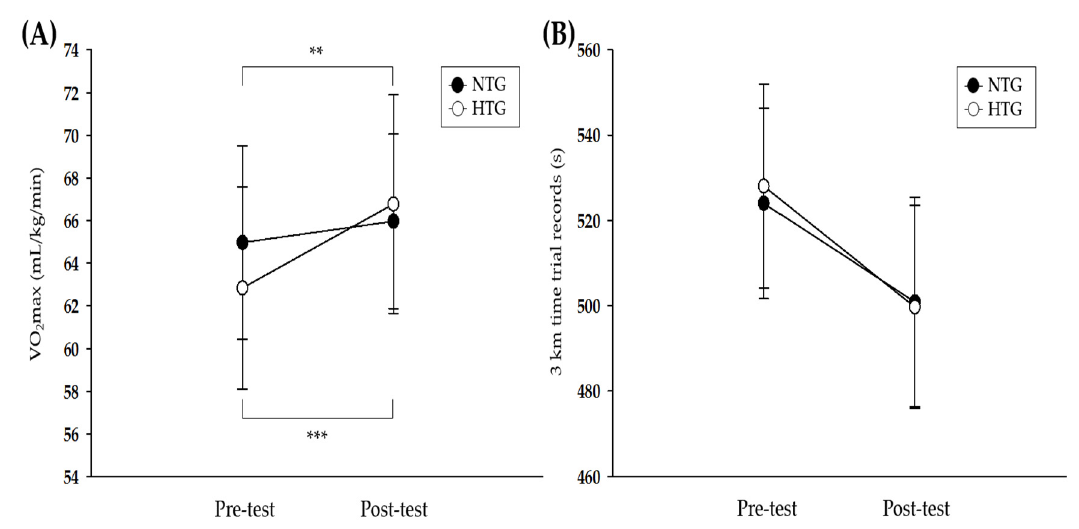
Figure 2. Athletic performance parameters before and after the 6-week exercise training. ( A ) Change in the VO 2 max after exercise training in each environmental condition. ( B ) Change in the 3-km time trial record after exercise training in each environmental condition. VO 2 max = maximum oxygen uptake, NTG = normoxic training group, HTG = hypoxic training group. * Significant difference between the pre- and post-tests, ** p < 0.01, *** p < 0.001.